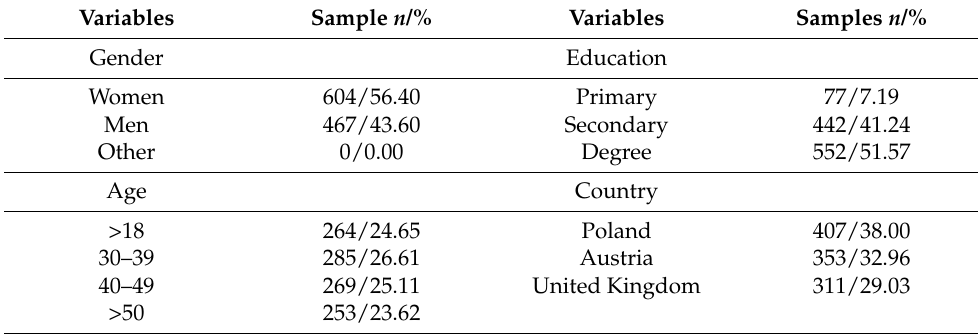
Table 1. Socio-demographic characteristics of 1071 adults who filled out the questionnaire.